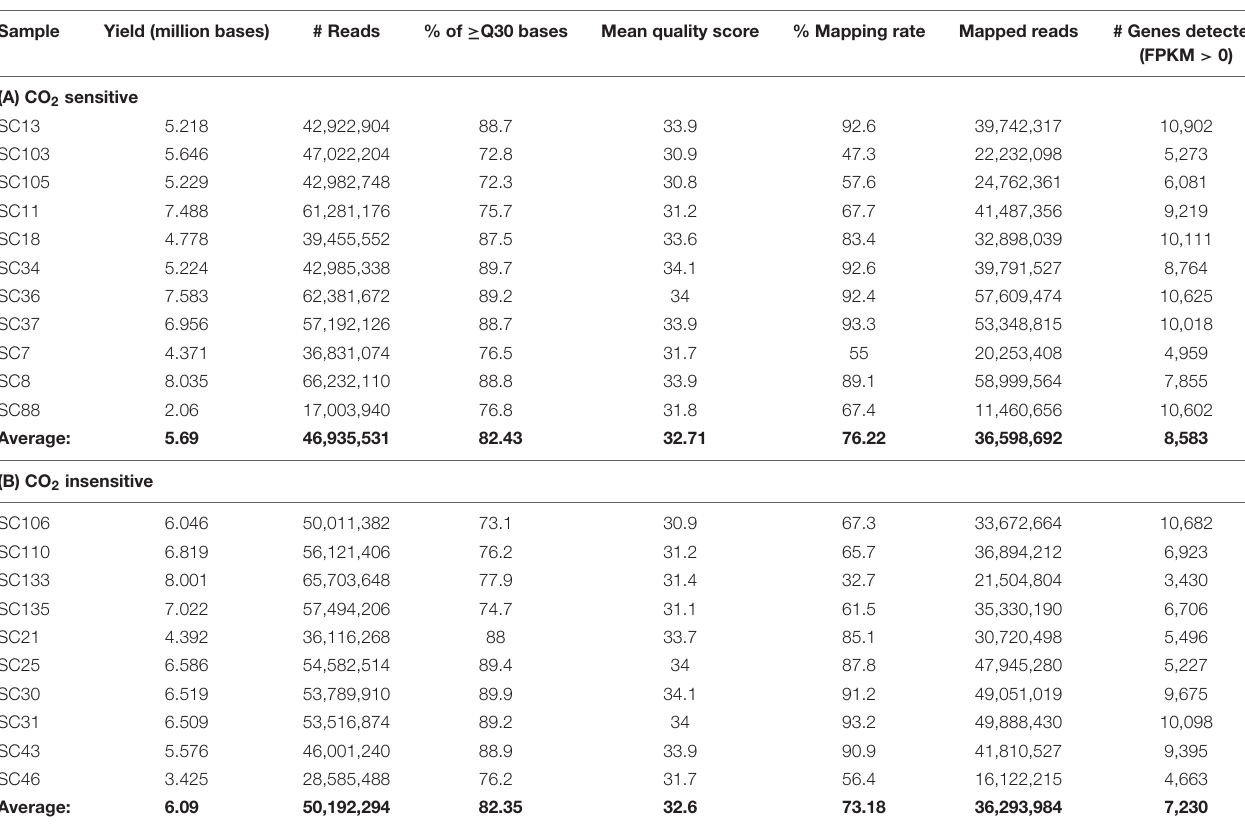
TABLE 1 | RNA sequencing read summary report for CO 2 sensitive (A) and insensitive 5-HT neurons (B) .